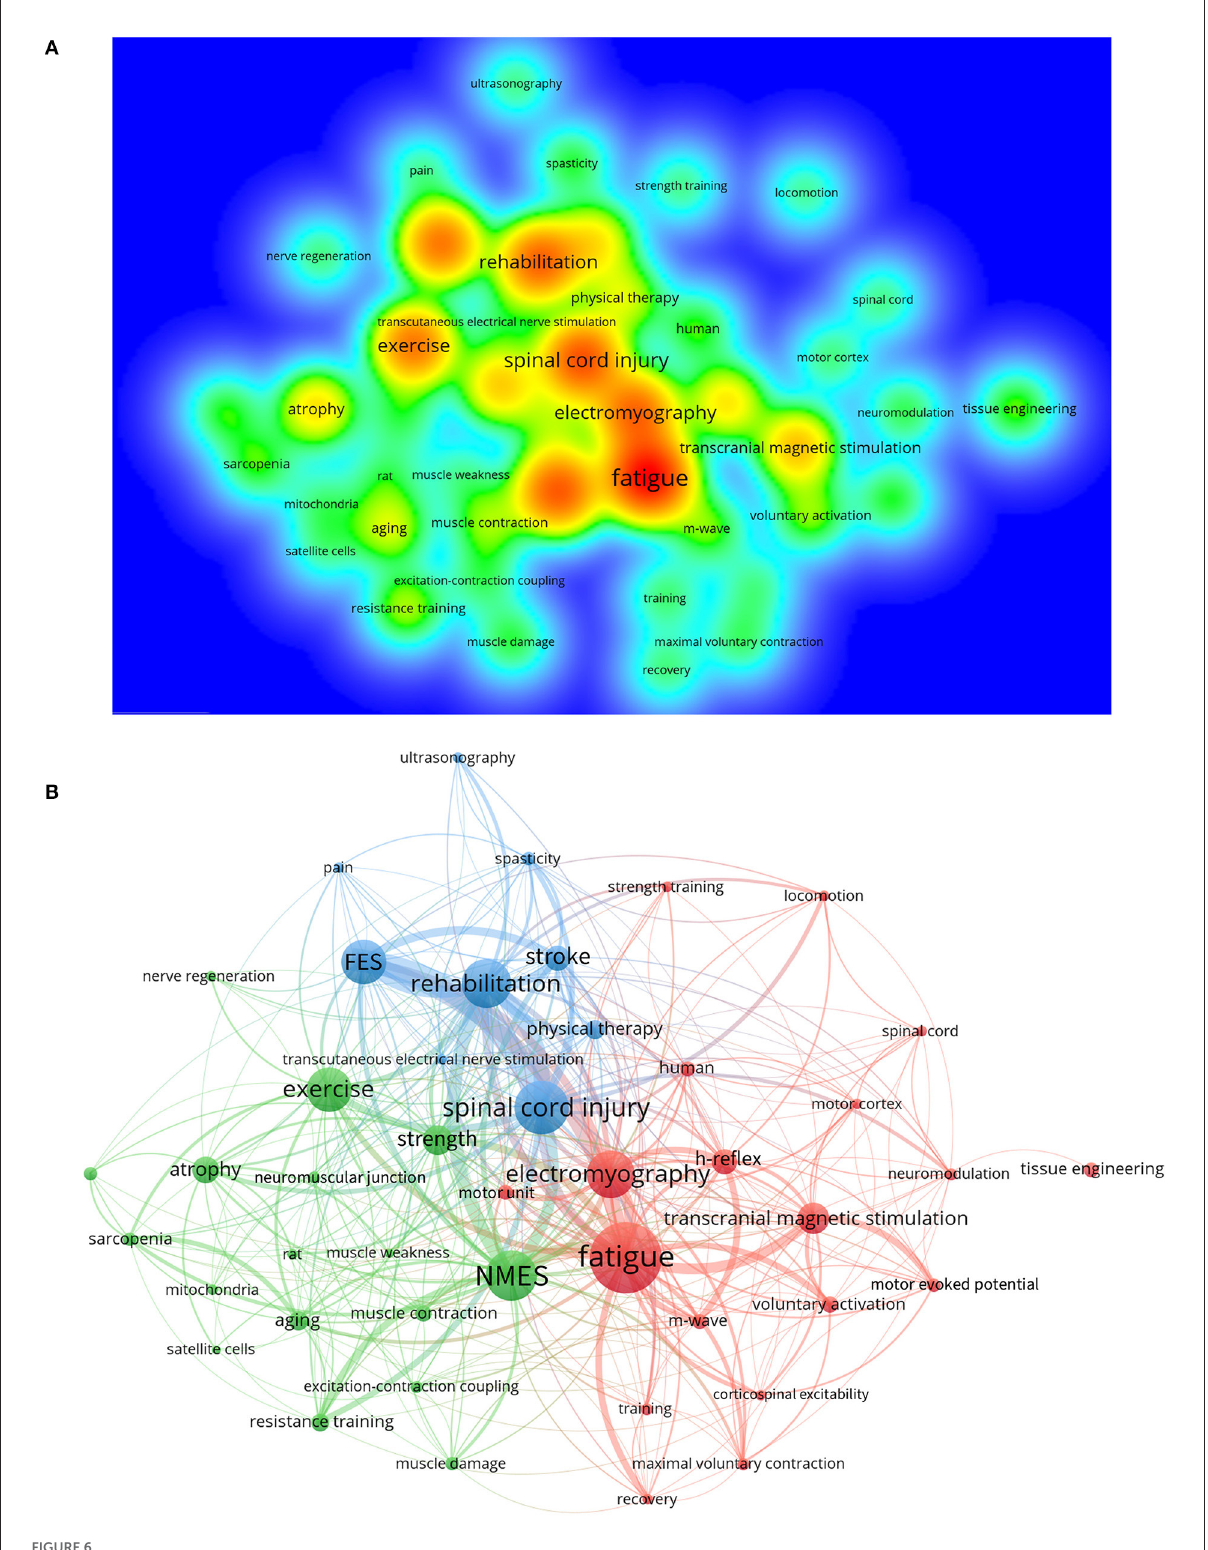
FIGURE6 Visualization of keywords. (A) Density map of keywords co-occurrence. (B) Cluster network map. Nodes of the same color form a